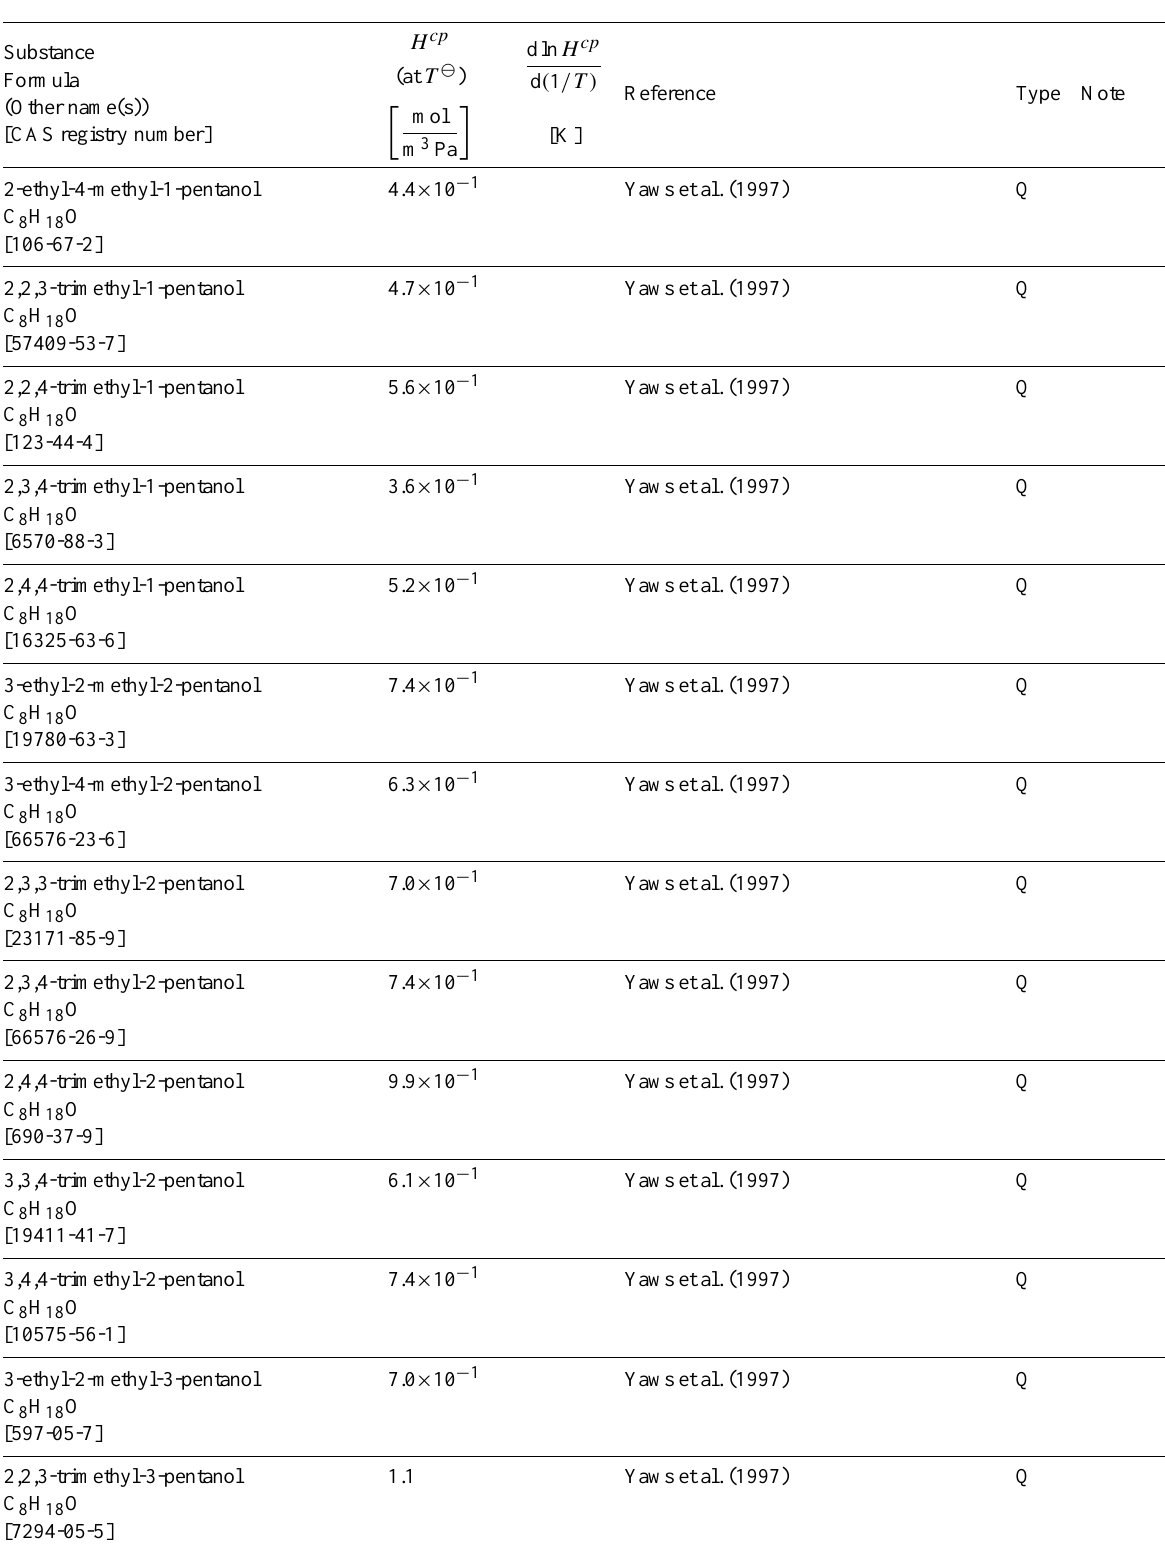
Table 6: Henry’s law constants for water as solvent